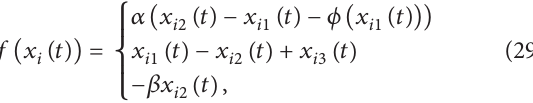
dynamical networks with delayed nodes, such as hybrid- coupled delayed neural networks with mixed probabilistic time-varying